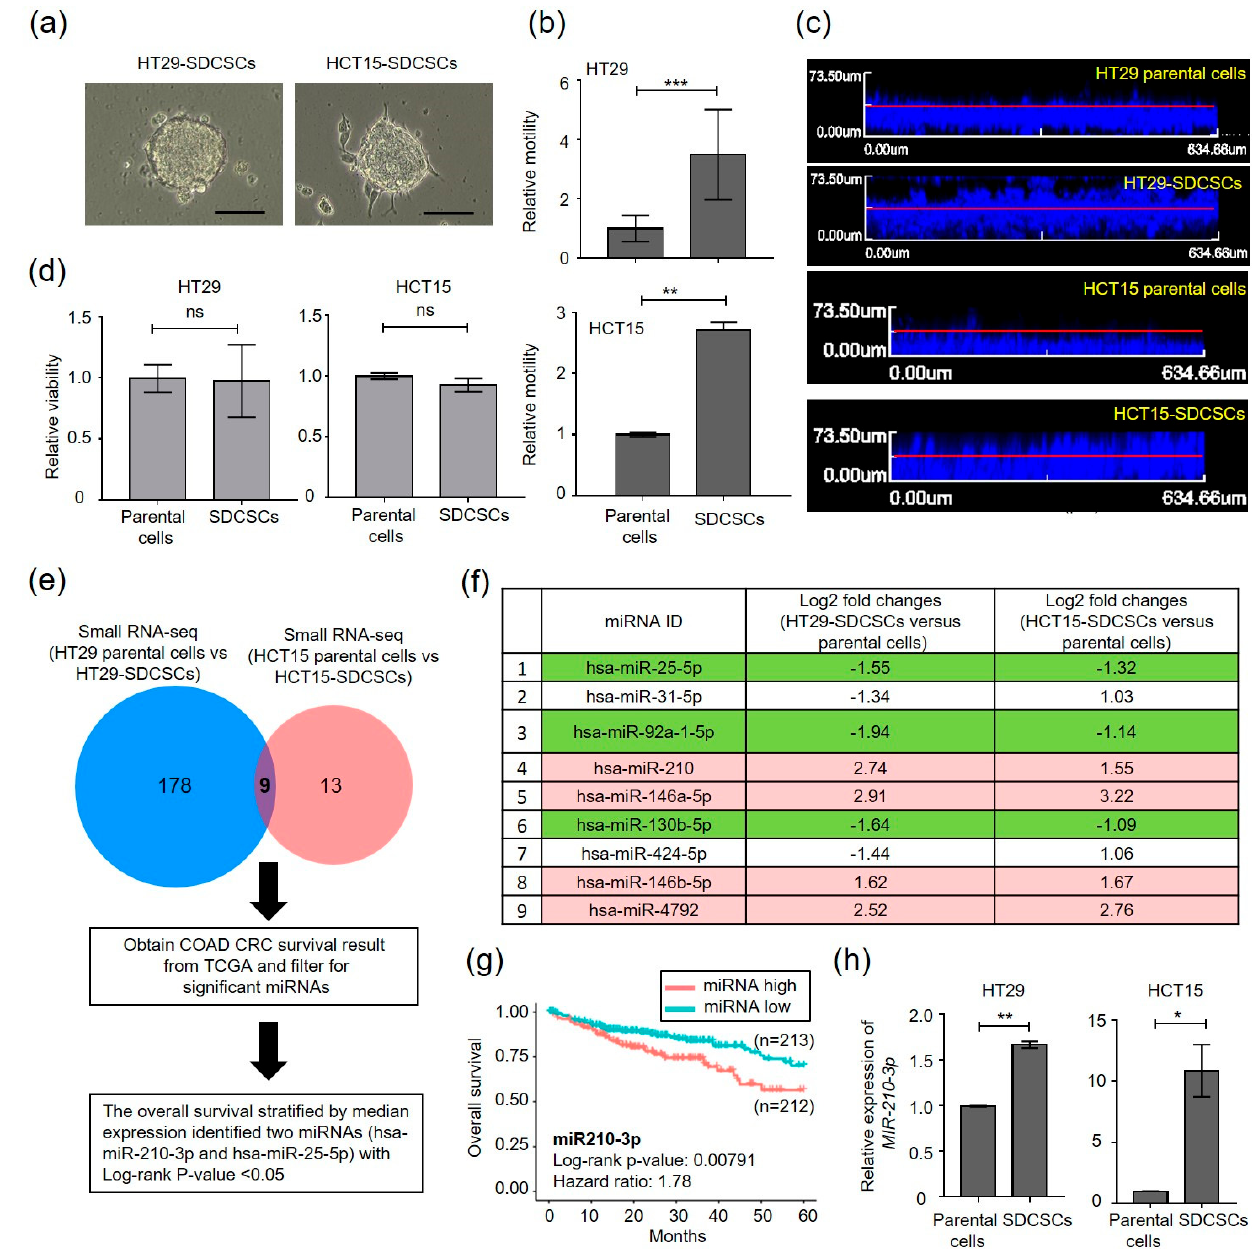
Figure 1. Increased expression of miR-210-3p in SDCSCs. ( a ) Representative images of SDCSCs from two CRC cell lines. SDCSCs, sphere-derived cancer stem cells. Scale bar, 100 μ m. ( b ) Histograms showing the relative transwell migration ability of cells. ( c ) Representative images of vertical invasion of cells. ( d ) Relative viability of cells as assessed by an MTT assay. ns, nonsignificant. ( e ) Flow charts for identifying differentially expressed miRNAs in the CRCSC miRNome associated with poor patient outcome in the TCGA-COAD dataset. The numbers of miRNAs with the same differential regulation patterns in HT29- and HCT15-SDCSCs are indicated in Venn diagrams. TCGA-COAD, The Cancer Genome Atlas Colon Adenocarcinoma. ( f ) A table illustrating the relative miRNA expression levels in SDCSCs. Red, miRNAs upregulated in both SDCSC lines. Green, miRNAs downregulated in both SDCSC lines. ( g ) Kaplan–Meier analysis of overall survival in patients in a TCGA-COAD dataset ( n = 425). The median miR-210-3p expression level was used for patient stratification. miRNA high, CRC patients with high miR-210-3p expression. miRNA low, patients with low miR-210-3p expression. The p- value was estimated by the log-rank test. ( h ) RT-qPCR validation of miR-210-3p expression in the indicated cells. Unless otherwise stated, all data in bar charts are expressed as the mean ± SD values. * p < 0.05; ** p < 0.01; *** p < 0.001 (Student’s t -test).